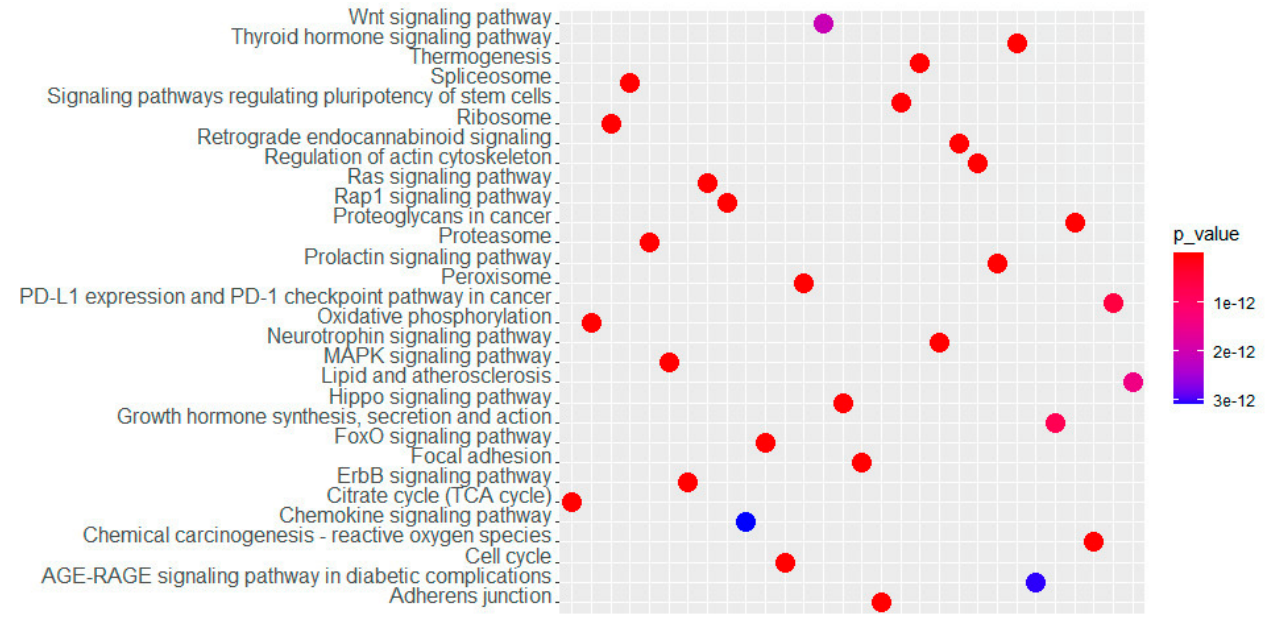
Figure 3. Pathway enrichment results using the KEGG database.